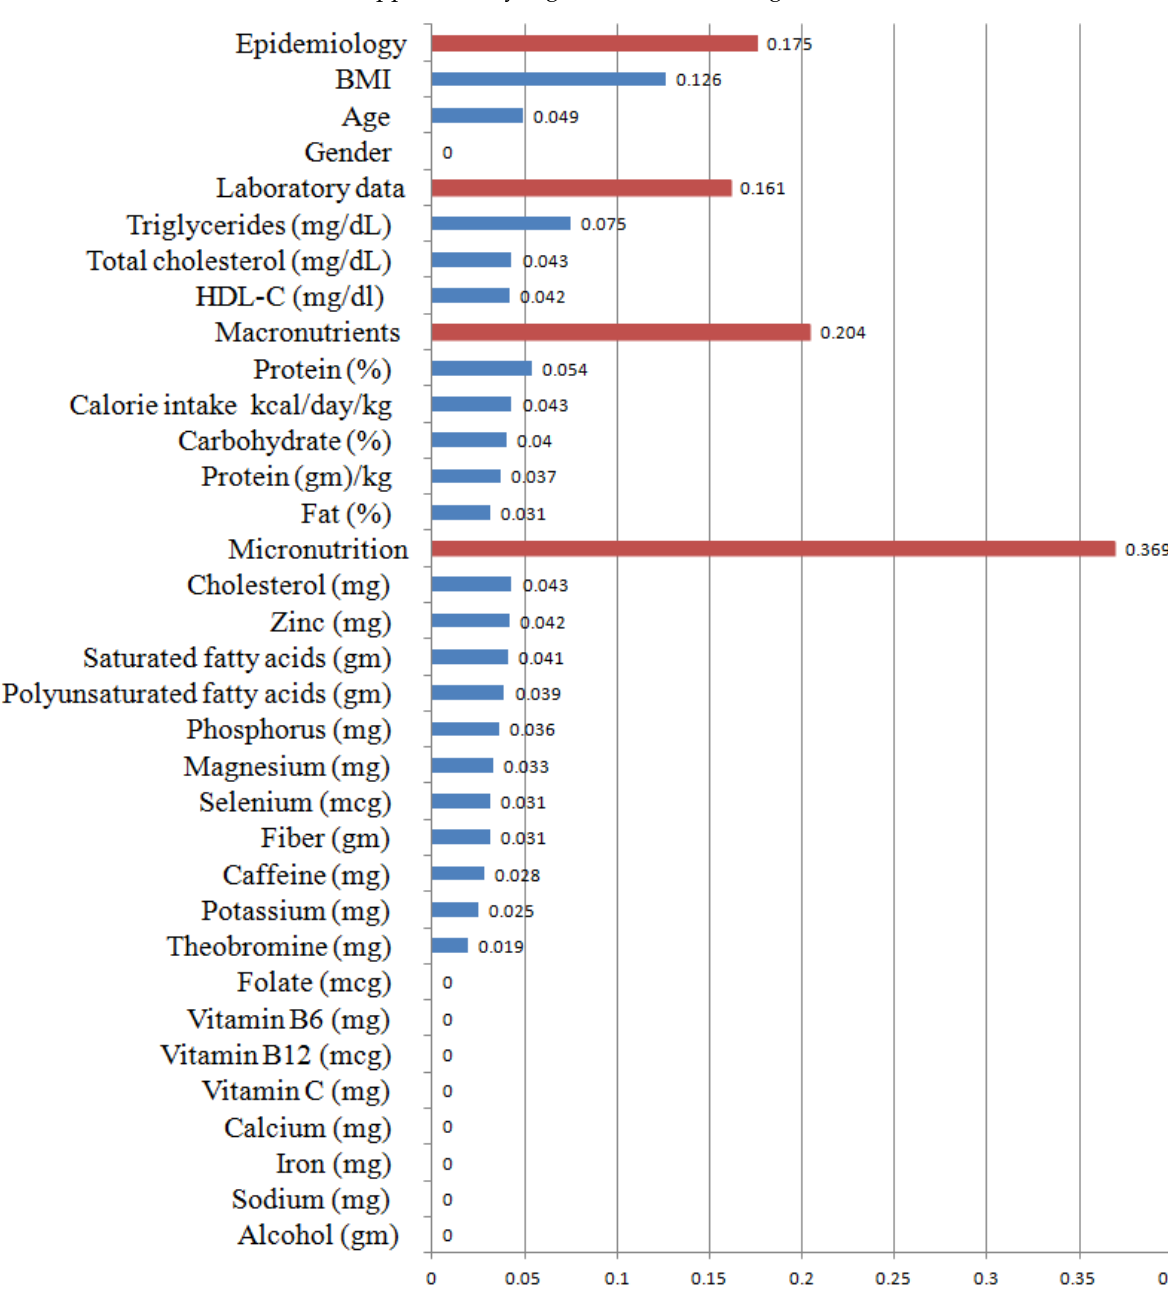
values for all features are showed in Supplementary Figure S1 for the XGBoost algorithm and in Supplementary Figure S2 for the RF algorithm.